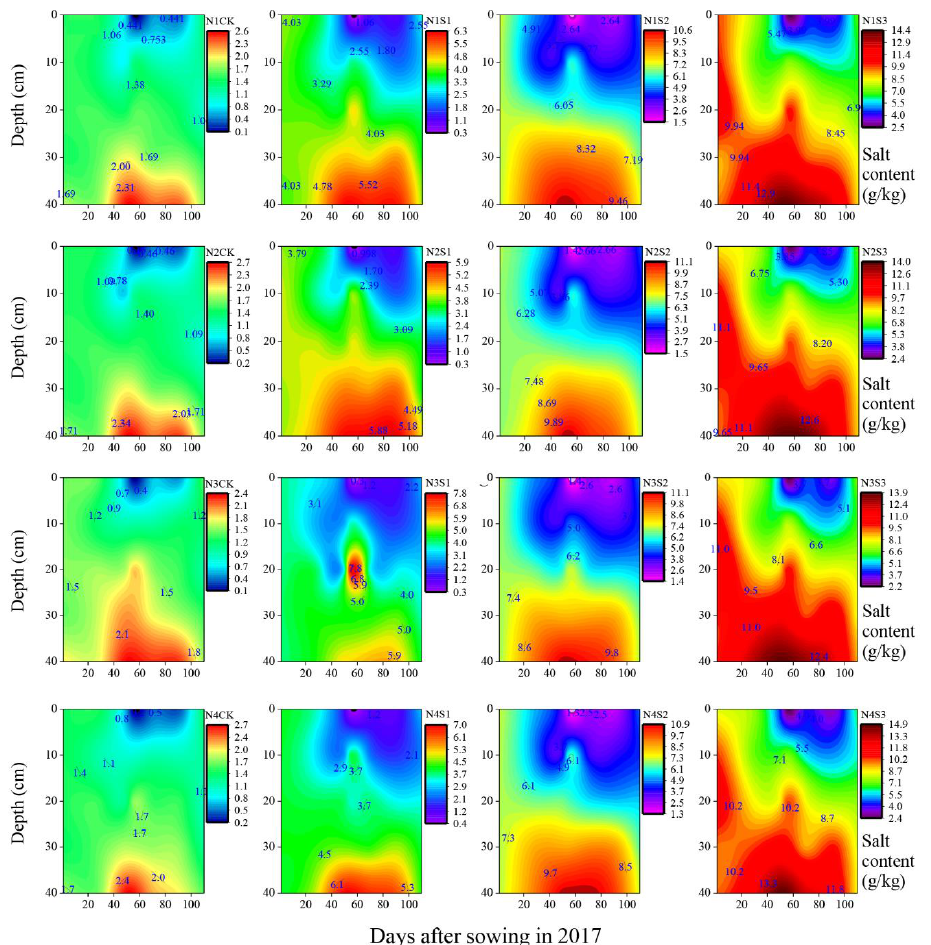
Figure 3. Dynamic distribution characteristics of salinity along the soil profile on different days after sowing in each treatment in 2017. From left to right, the application rate of salt increases. From up to down, the application rate of nitrogen increases.